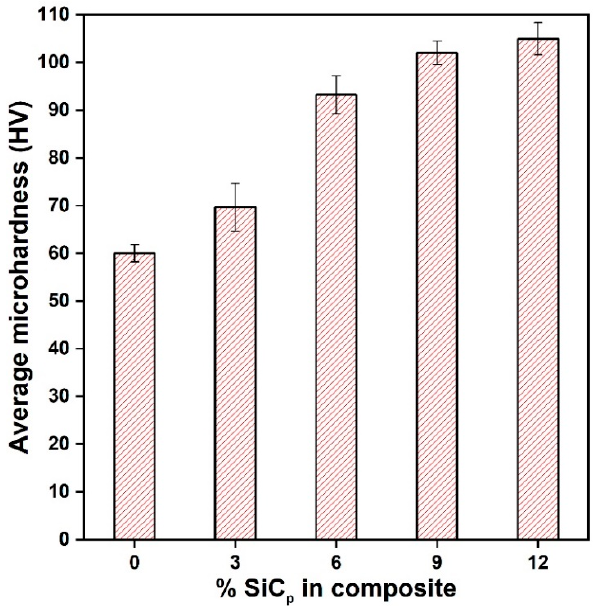
Figure 2. Microhardness of different composites with varying content of SiC.